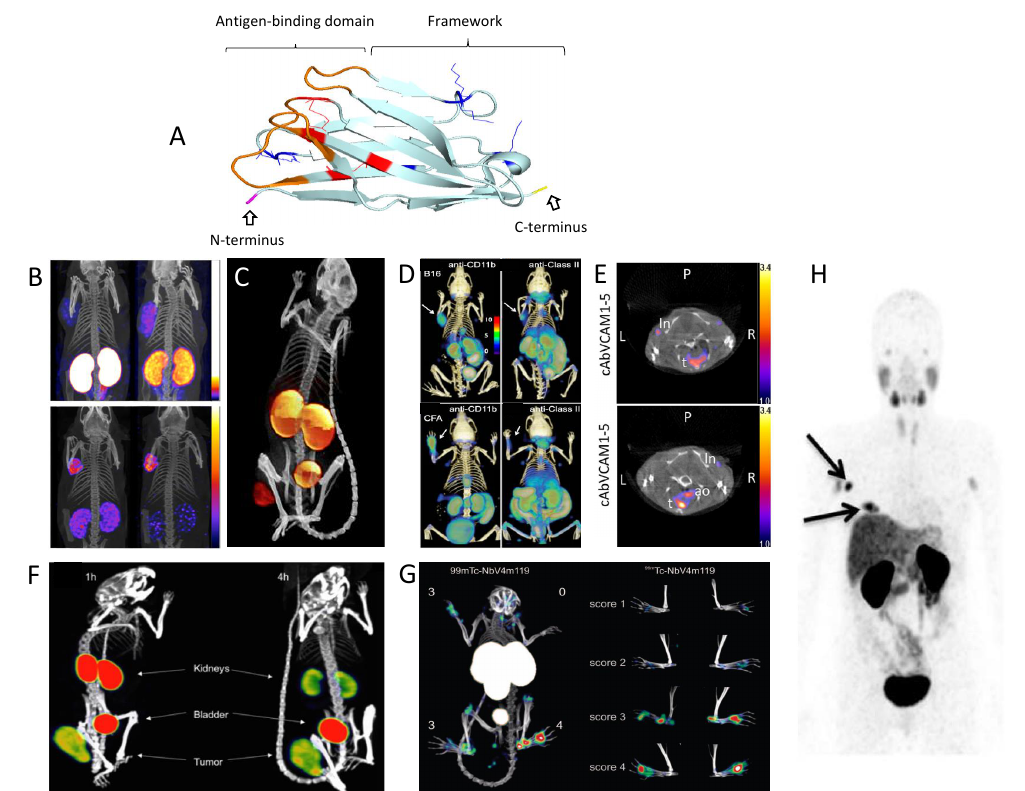
Figure 1. Schematic representation of the structure of a nanobody and illustrative positron emission tomography (PET) and single photon emission computed tomography (SPECT) preclinical and